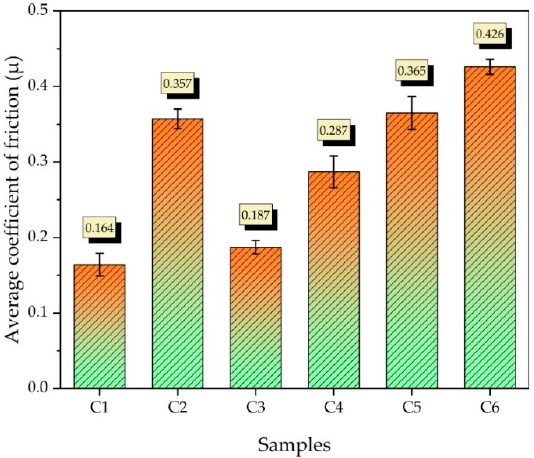
Figure 14. Average friction coefficient of samples produced at different ratios. Figure 15 represents the temperature graph generated during the wear tests. Tem- peratures were recorded by measuring every 200 m of wear distance. When the graph is inspected, it is clear that the rising temperatures are directly proportional to the rein- forcement ratios. It was observed that the temperature also increased in each measure- ment interval. The highest temperature was recorded as 41.4 °C in sample no C6 (Cu-6Gr/3SiC-3WC). The fact that the C6 sample has the highest average friction coeffi- cient supports this situation (highest temperature). As the friction coefficient increases, the temperature also increases. Figure 15. Temperature change on the sample surface during the wear test. 4. Conclusions In this study, double-reinforced copper composites were produced with the lubri- cant graphite, which has not been encountered before in the literature. The current study investigates the effect of adding SiC–WC particles to Cu-6Gr composites. The aim is to study the effect of the reinforcement ratio on several mechanical properties of the newly developed Cu-6Gr/SiC-WC composites. Density, hardness, wear rate, and flexural strength were evaluated, and the effect of reinforcement ratio was determined. SEM and EDS analysis were performed to study the developed composites at a microstructural